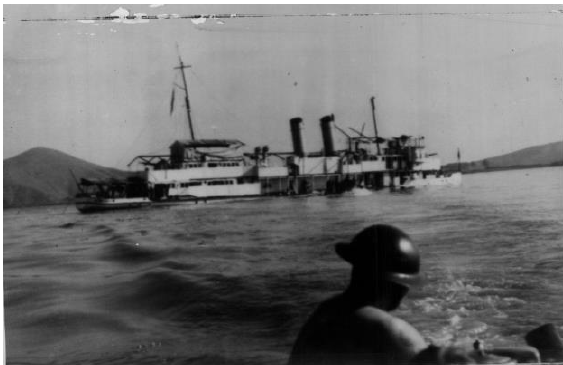
Figure 2. Sinking of the SS Panay . Source: The Denver Post/ Getty